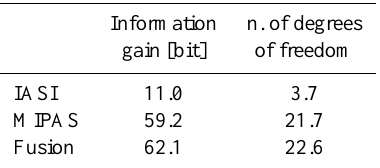
Table 1. Information gain and number of degrees of freedom for the profiles retrieved from simulated measurements using only the IASI measurement, only the MIPAS measurement and the IASI-MIPAS data